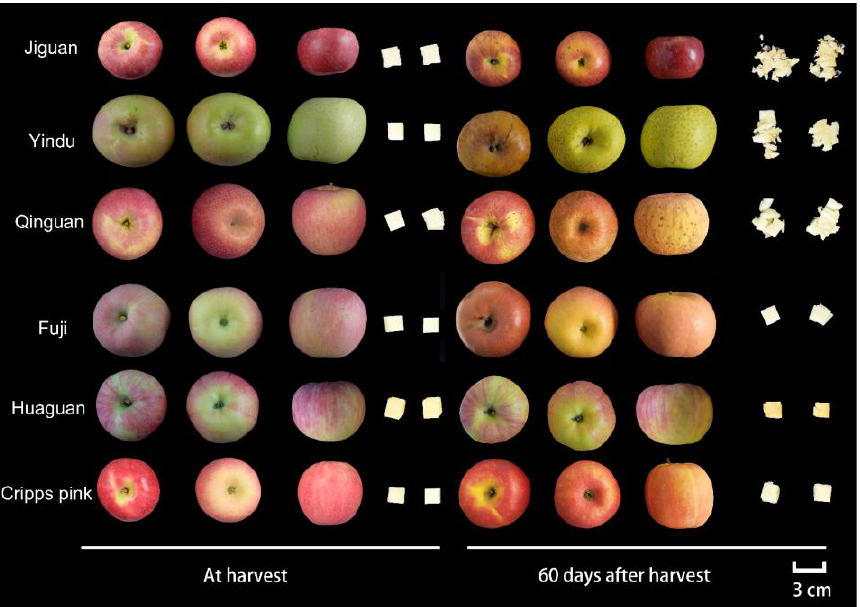
Figure 2. Appearance of ‘Jiguan’, ‘Yindu’, ‘Qinguan’, ‘Fuji’, ‘Huaguan’ , and ‘Cripps pink’ apple fruit stored at 25 ± 1 °C for 0 and 60 d. The pulp of 15 × 15 × 15 mm cube represents the shape of the apple pulp after being pressed by 75 N force using a TA-XT plus texture analyzer (Stable Micro Systems Ltd., Godalming, UK).